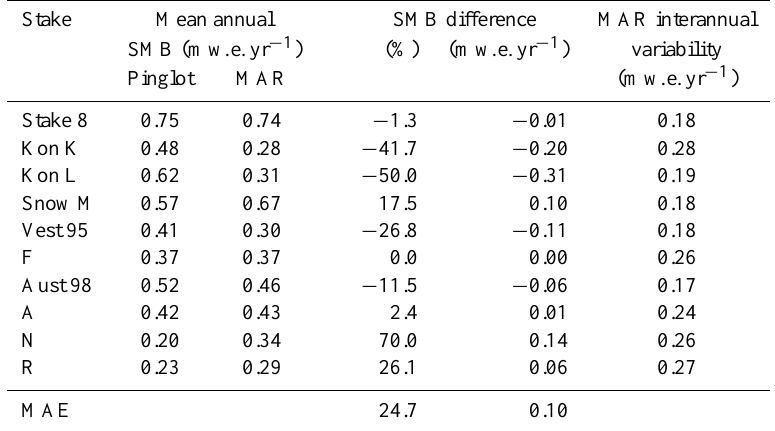
Table 6. Annual measured SMB (mw . e . yr − 1 ) from Pinglot et al. (1999, 2001) and simulated by MAR ERA , SMB difference (% and mw . e . yr − 1 ) between the MAR outputs and the measurements, MAR interannual variability of the SMB (mw . e . yr − 1 ). MAE = Mean abso- lute error.